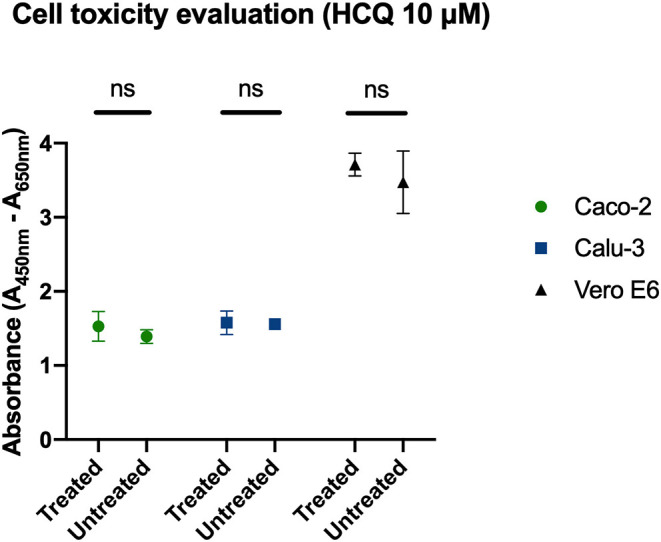
Determination of cell viability with HCQ treatment. Full-time treatment of Caco-2, Calu-3, Vero E6 cells with 10 μM HCQ does not affect cell viability. Mean and SD of optical density, ns = P > 0.05.